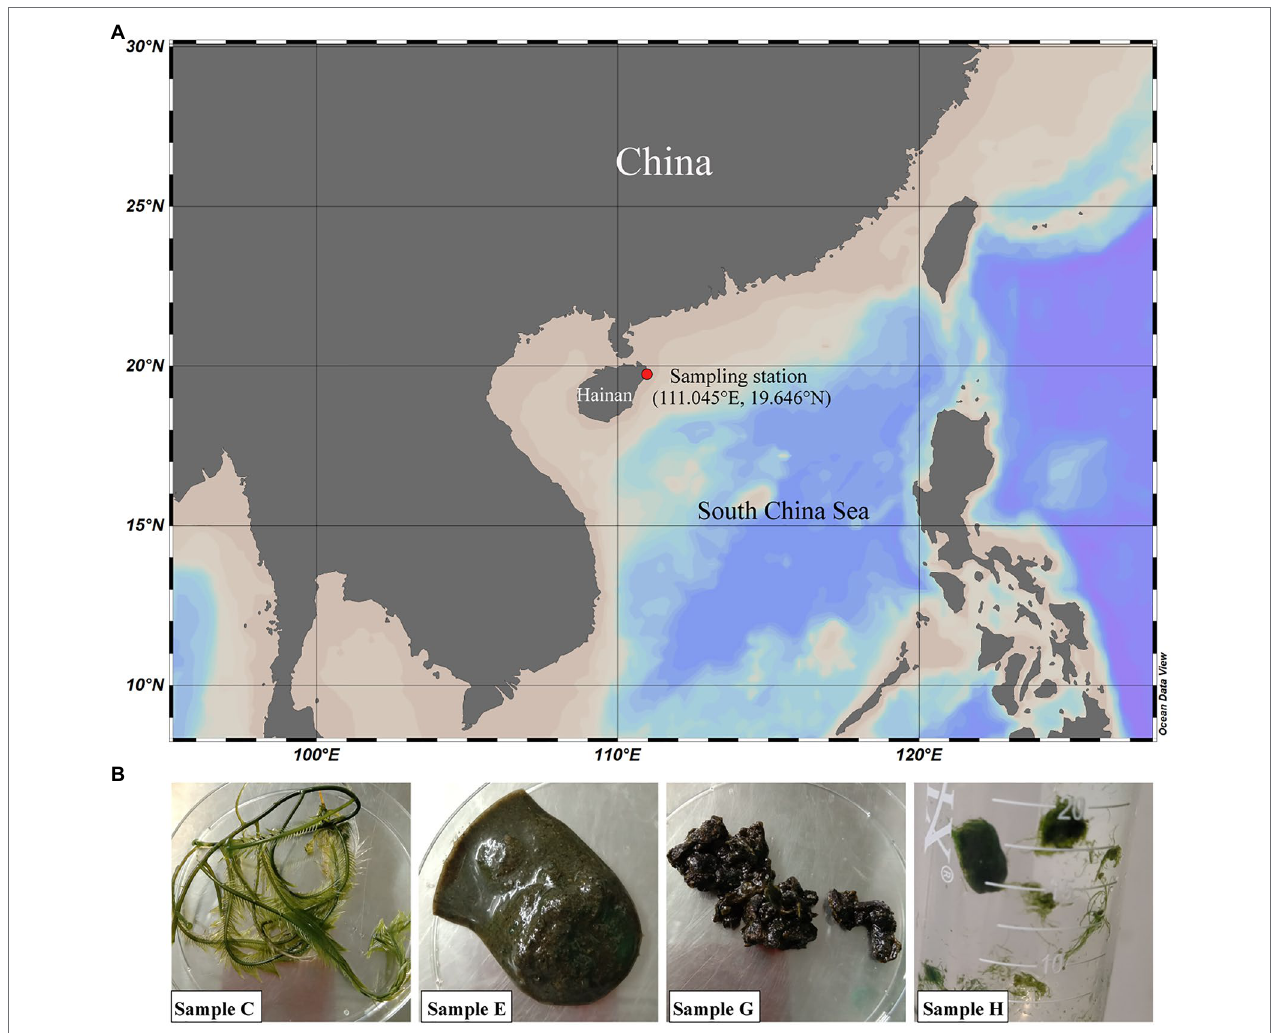
FIGURE 1 | Geographic location of the sampling station (A) and sample images (B) . At the sampling station, fresh and rotten seaweeds were collected from a Caulerpa lentillifera aquaculture base (samples C, E, and H) and the nearby beach (sample G) in Wenchang, Hainan, China. Samples C, E, G, and H are Caulerpa sertularioides , rotten Caulerpa lentillifera , unknown rotten algae and Chaetomorpha sp.,